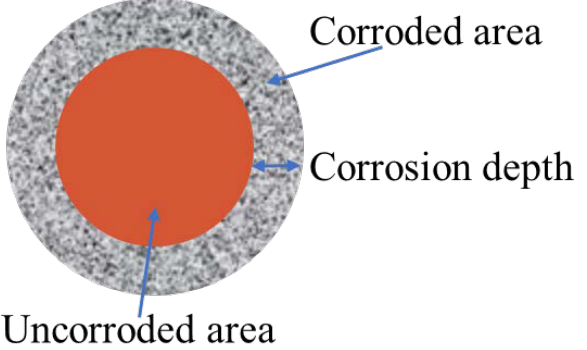
Figure 1. Schematic diagram of corrosion depth.